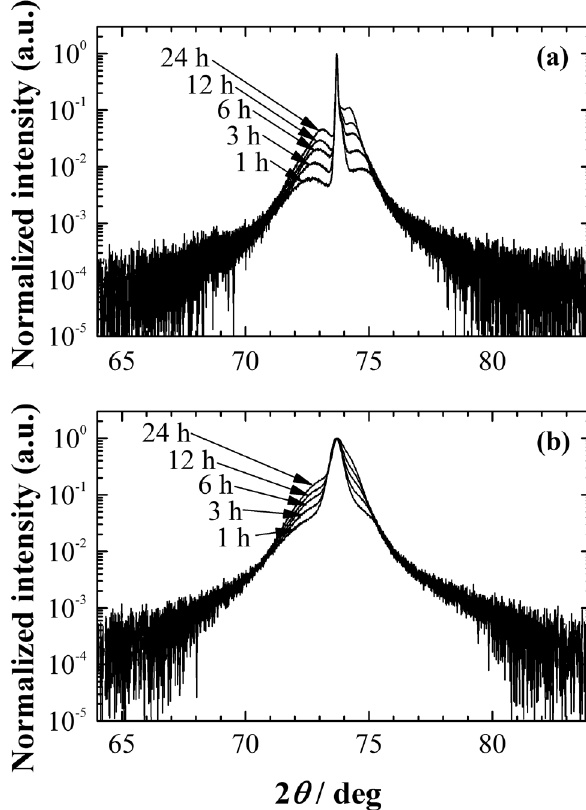
Fig. 4: Progress of sideband peaks appearing in the 220 reflection of (a) ST and (b) ST + CR specimens with aging at 723